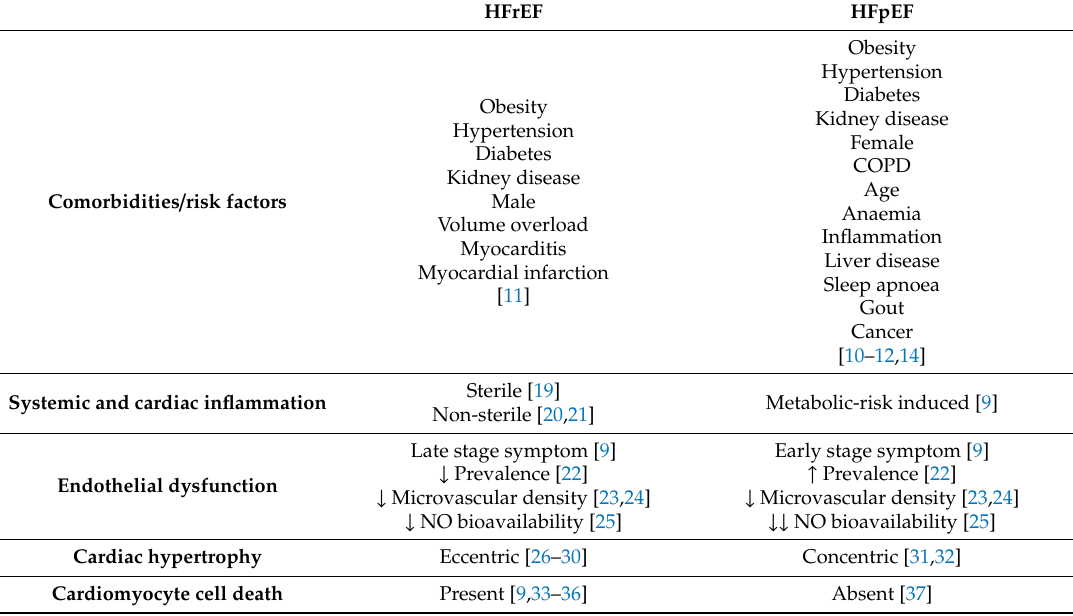
Table 1. Summary of physiological, cellular and molecular similarities and di ff erences between HFrEF and